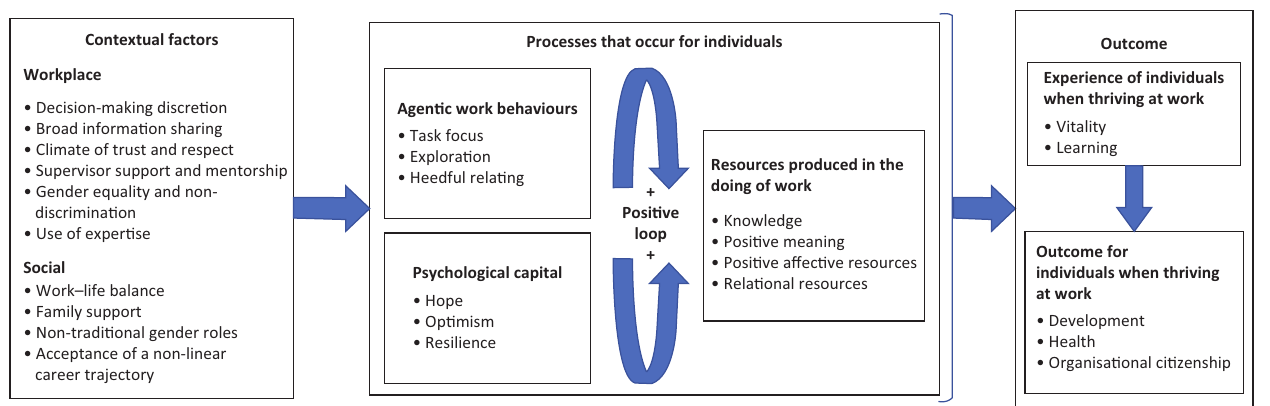
FIGURE 1: Framework for women doctors’ thriving at